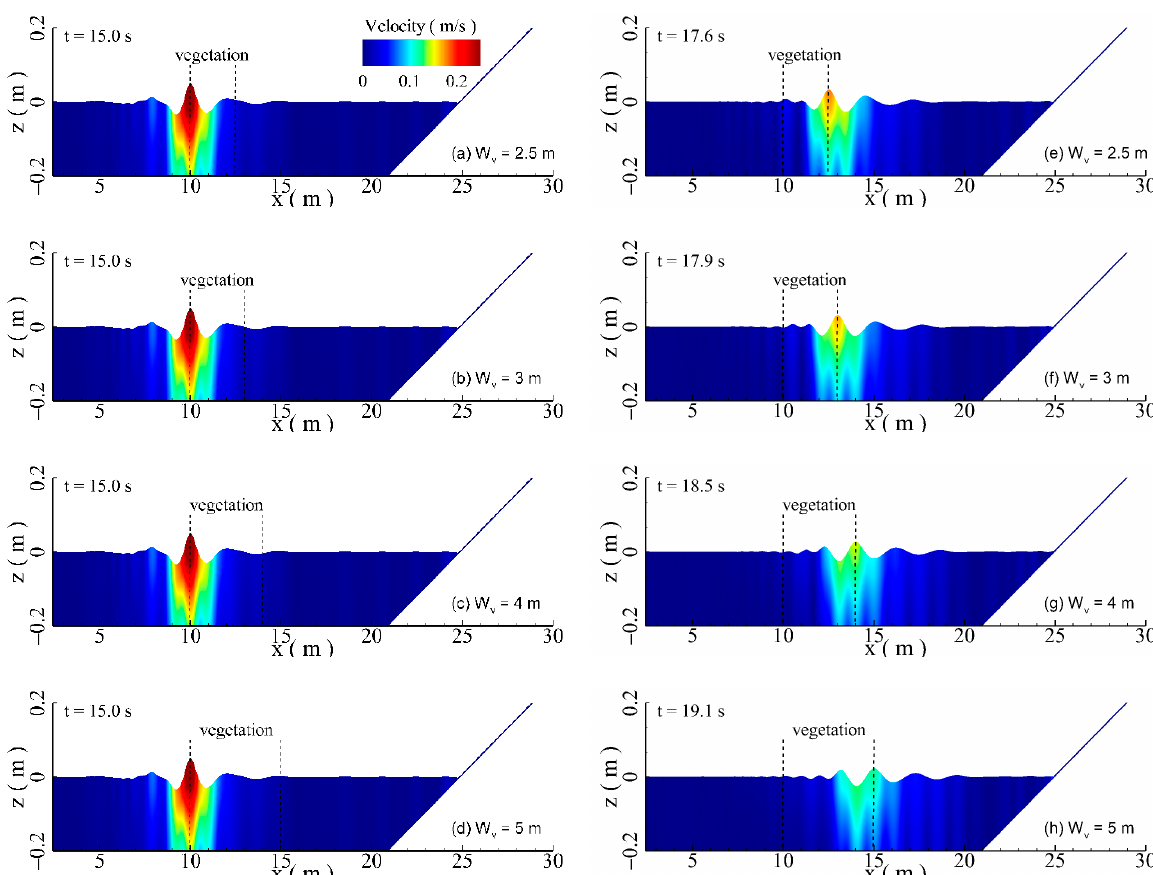
Figure 29. Water velocity contours under different vegetation lengths at different times.